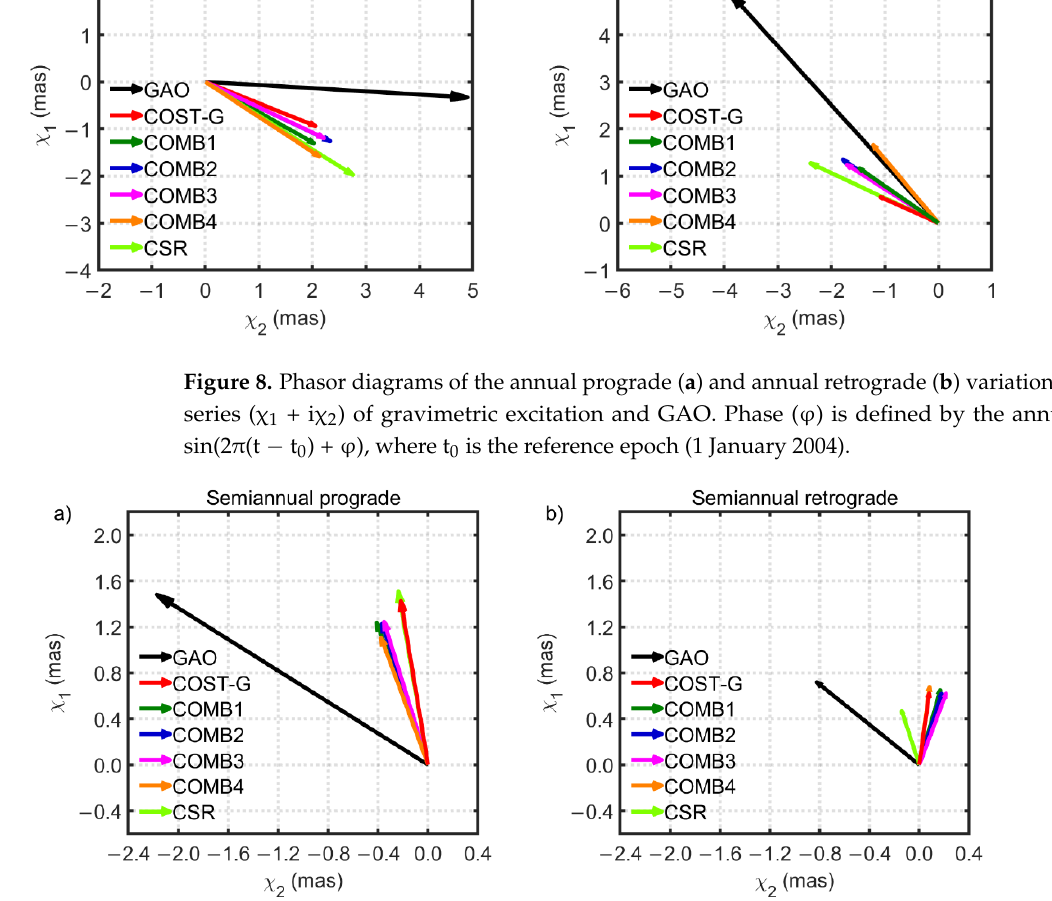
Figure 8. Phasor diagrams of the annual prograde ( a ) and annual retrograde ( b ) variation in complex series (χ 1 + iχ 2 ) of gravimetric excitation and GAO. Phase (φ) is defined by the annual term as sin(2π(t − t 0 ) + φ), where t 0 is the reference epoch (1 January 2004).